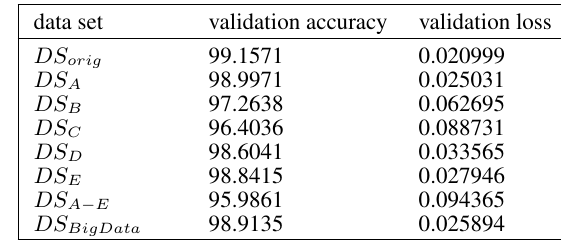
Table 3. List of training data sets.